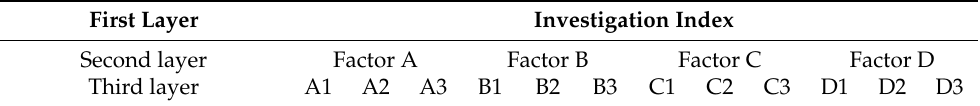
Table 2. Data structural of multi-target orthogonal test.